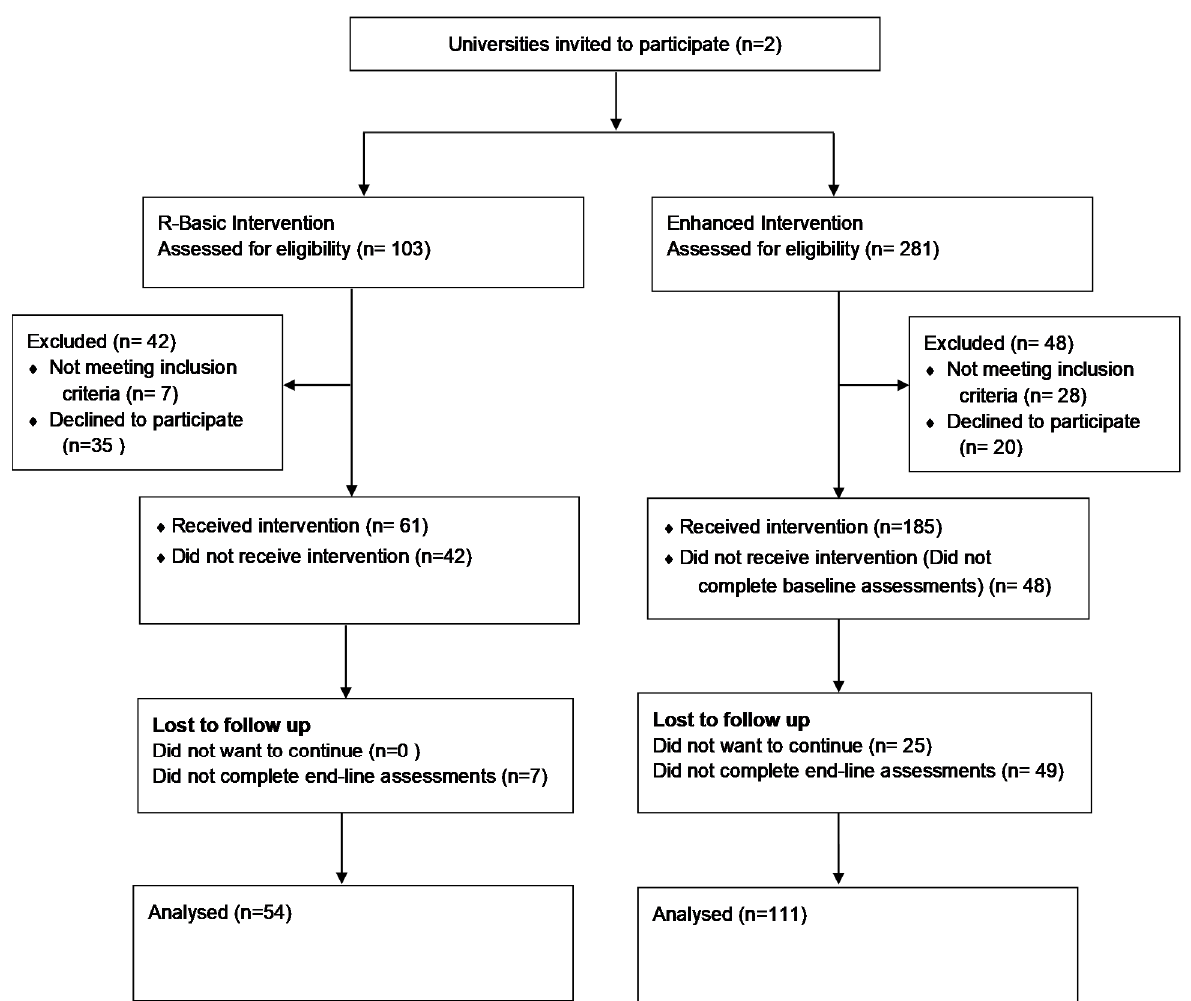
Figure 1. Flow of participants in the Fitness for Me program.